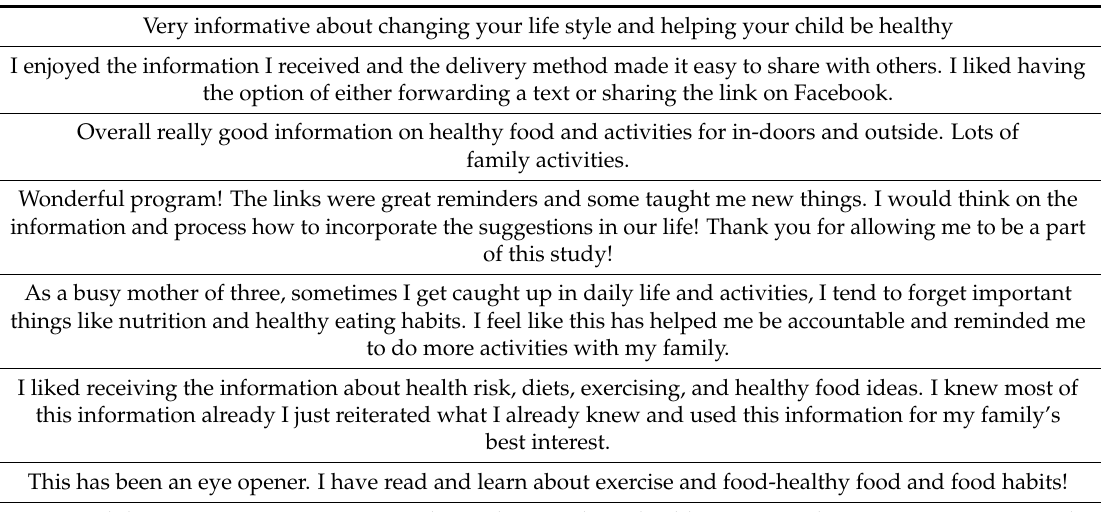
Table 3. Parent post-intervention survey